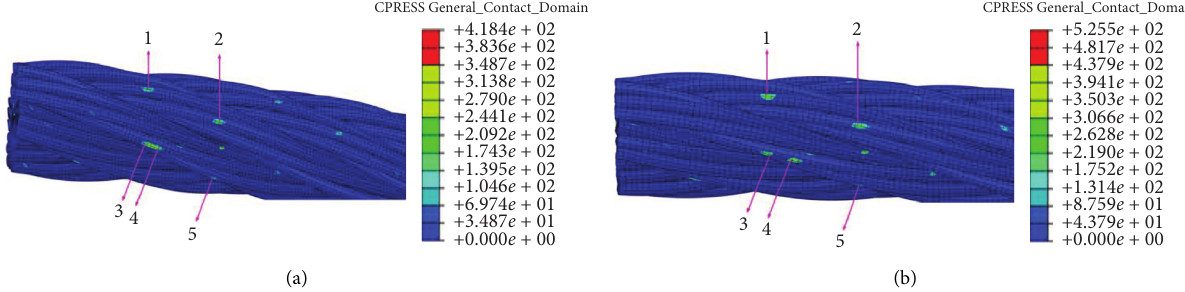
Figure 13: Comparison of contact stress on continuous and discontinuous wire rope. (a) Contact stress distribution on the continuous model wire rope. (b) Contact stress distribution on the discontinuous model wire rope.